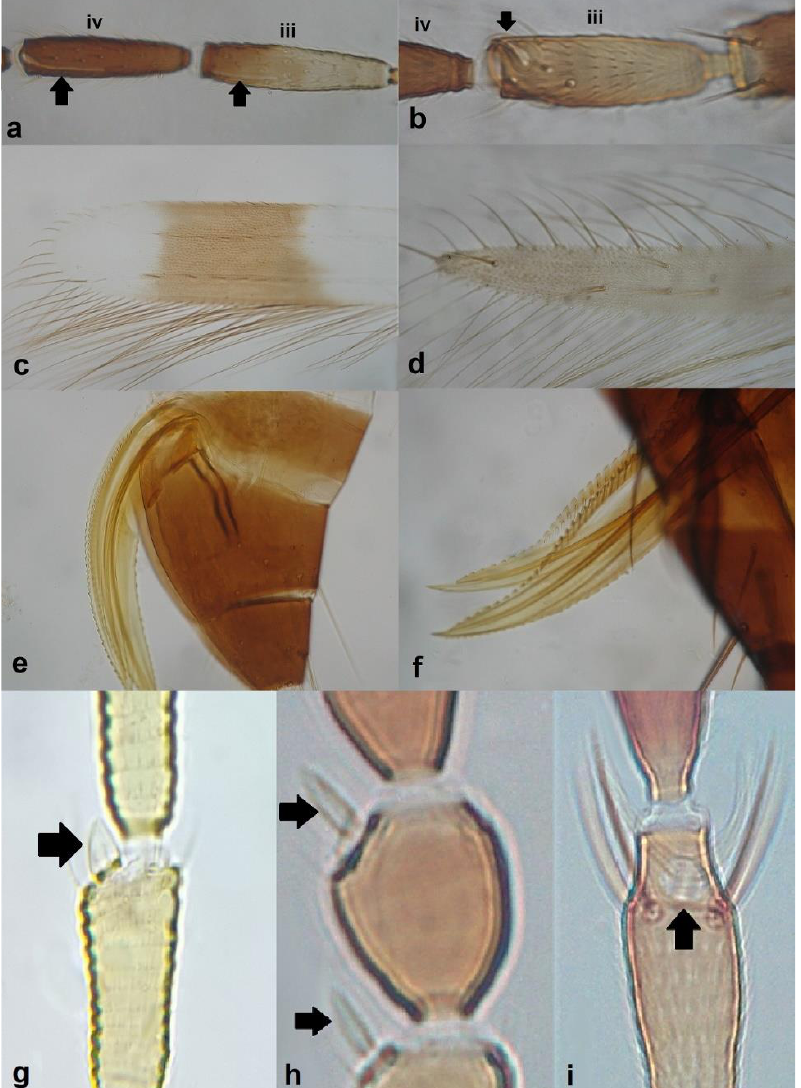
Figure 3. Sensoria on antennal segments III and IV ( a , b ): ( a ) parallel to length of segment; ( b ) perpendicular to length of segment; fore wing tip ( c , d ): ( c ) broad; ( d ) narrows apically; ovipositor ( e , f ): ( e ) curving upwards towards body: ( f ) curving downwards; antennal sensoria on segments III and IV ( g,i ): ( g ) cone-shaped; ( h ) simple or hair-like; ( i ) forked.